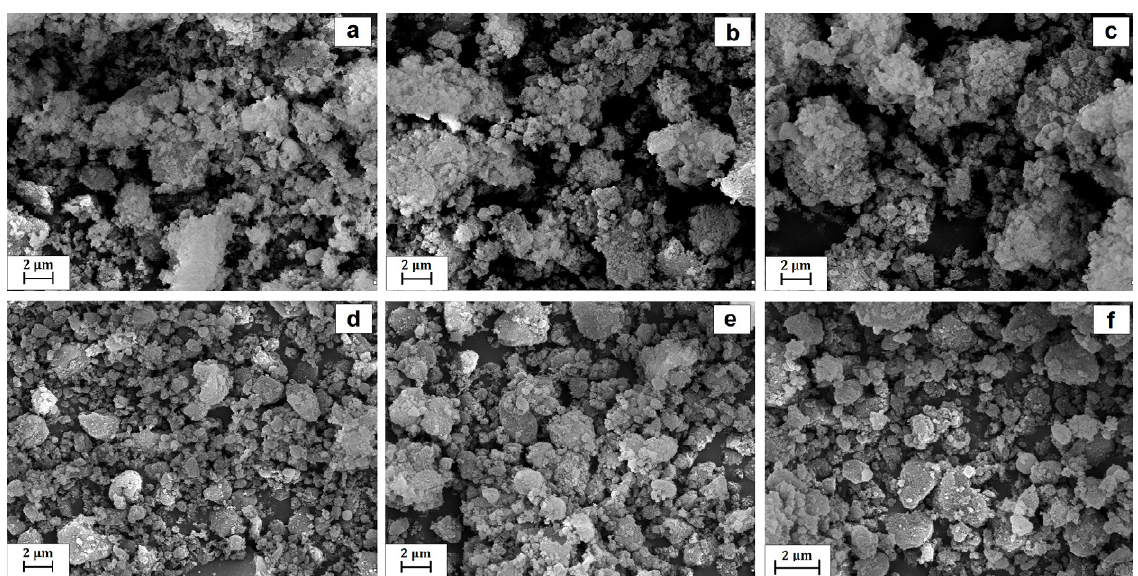
Figure 5. SEM images of silica/lignin hybrids obtained from hydrated silica (a-c) and Aerosil ® 200 (d-f) containing respectively 3, 20 and 50 parts by weight of Kraft lignin.